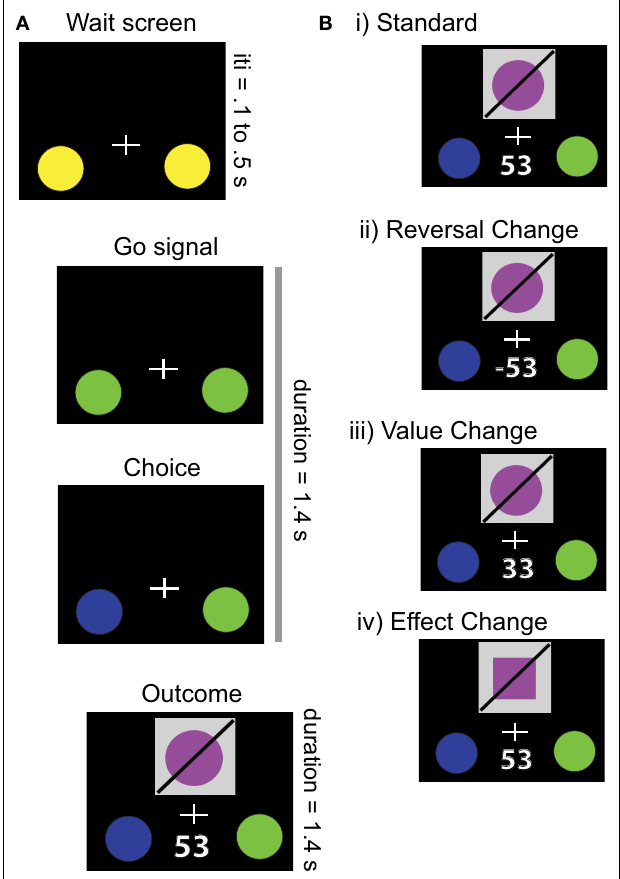
FIGURE 1 | Task. (A) Example trial structure. Following an initial stimulus display, the onset of the trial was signaled by a change in color of the response circles. When the participant indicated the choice for that trial, the selected option changed color, whereupon the outcome of the trial was indicated by a visual object and a monetary reward. Trials were each 2.8 s, with 1.4 s for response and choice presentation and 1.4 s for outcome presentation. Intertrial intervals ranged between 0.1 and 0.5 s, to prevent subjects from predicting the onset of each trial. (B) Possible outcomes derived from different changes in contingencies. On Standard trials , the outcome was maintained from the prior trial. In Reversal Changes , the action-outcome contingencies switch, and thus the participant loses the amount of money they were expecting to gain. In Value Changes , the participant gains money, but either more or less than they expected. Finally, in Effect Changes , the participant receives the amount of money they were expecting, but the visual stimulus